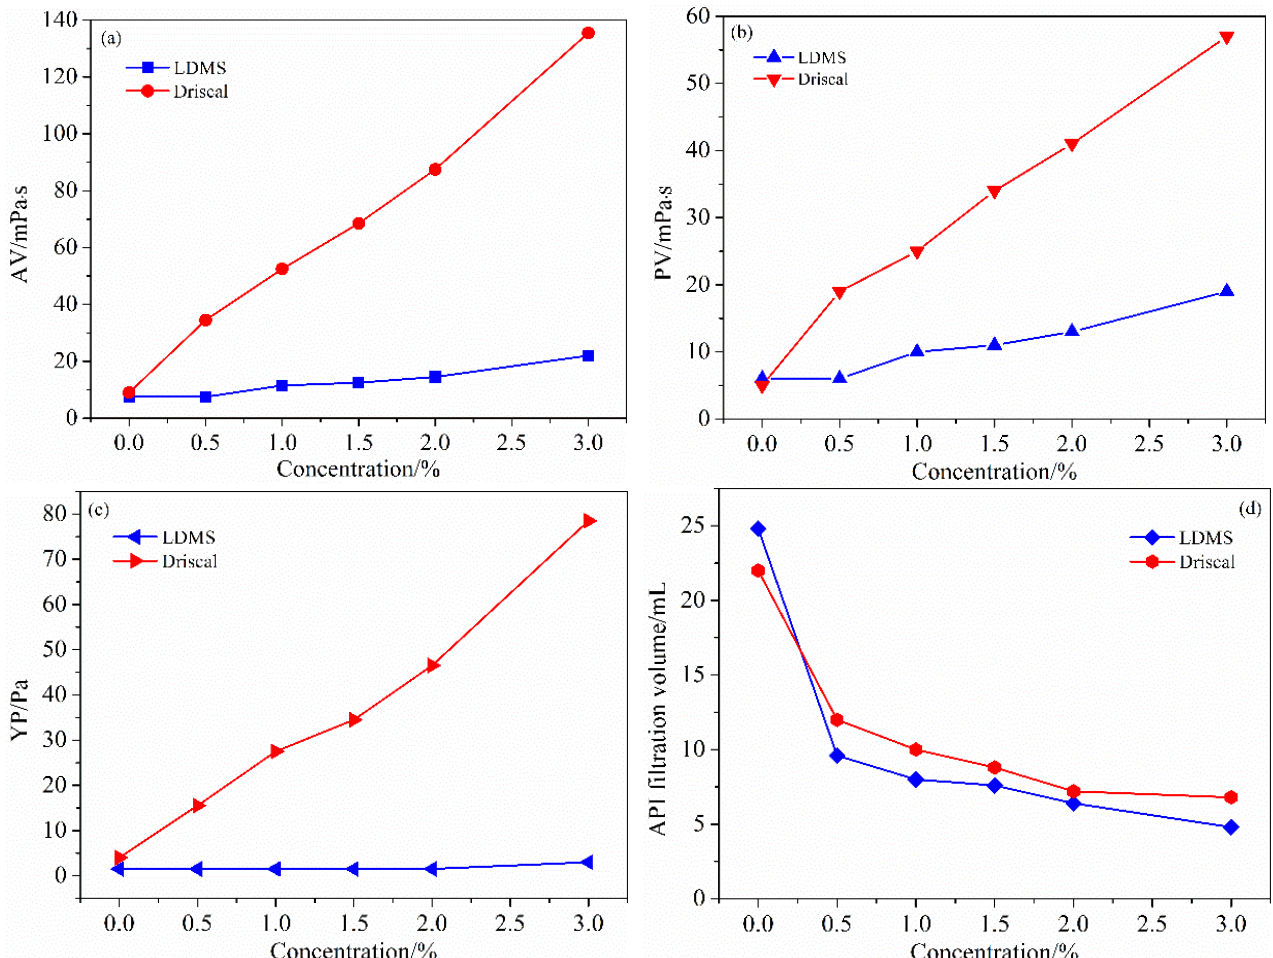
Figure 5. Effect of concentration on the AV ( a ), PV ( b ), YP ( c ), and API filtration ( d ) of drilling fluids.